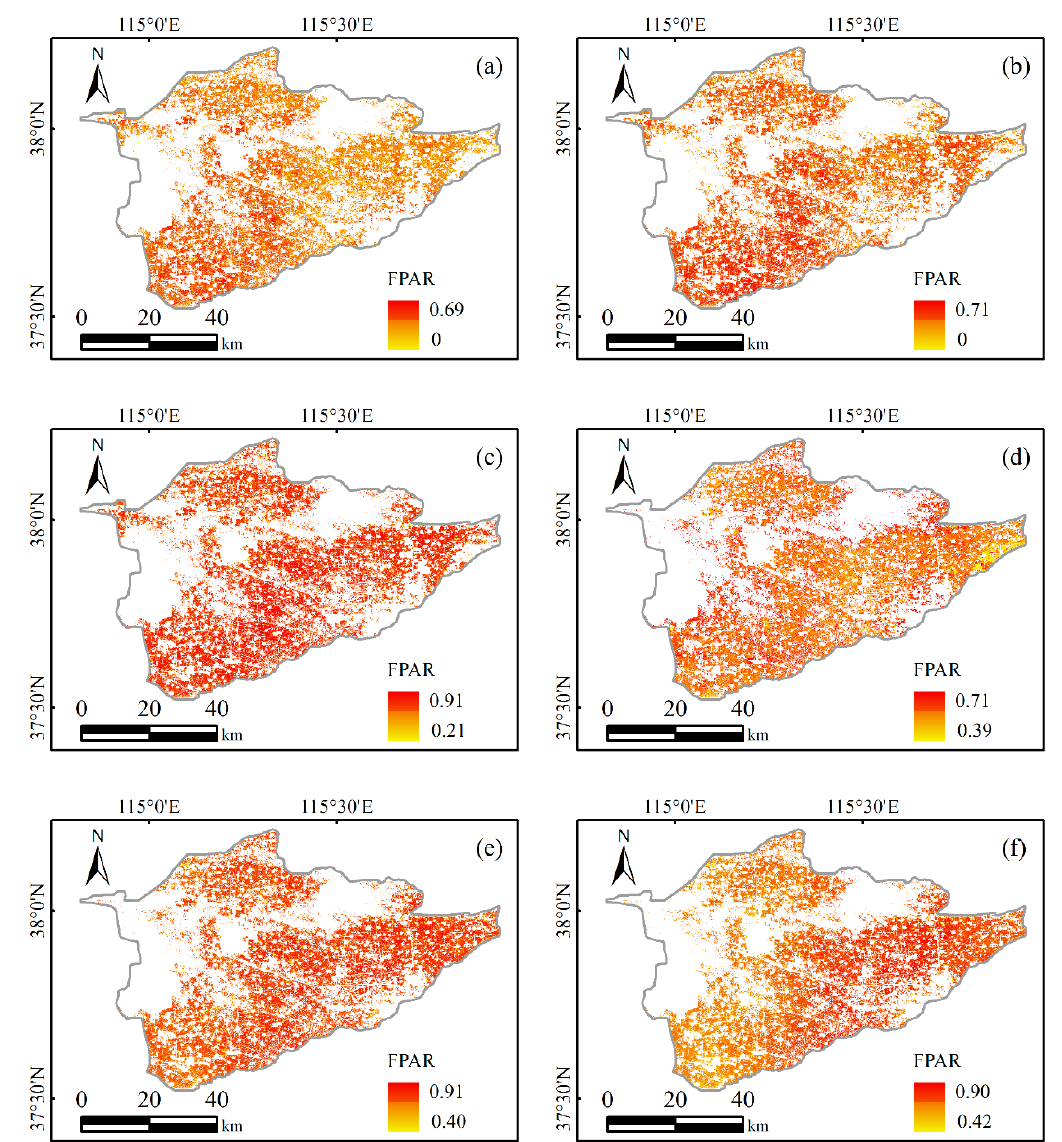
Figure 8. The spatial distribution of the FPAR of crops in the main growing season. ( a – c ) Spatial distribution of the FPAR of winter wheat from March to May. ( d – f ) Spatial distribution of the FPAR of maize from July to September.